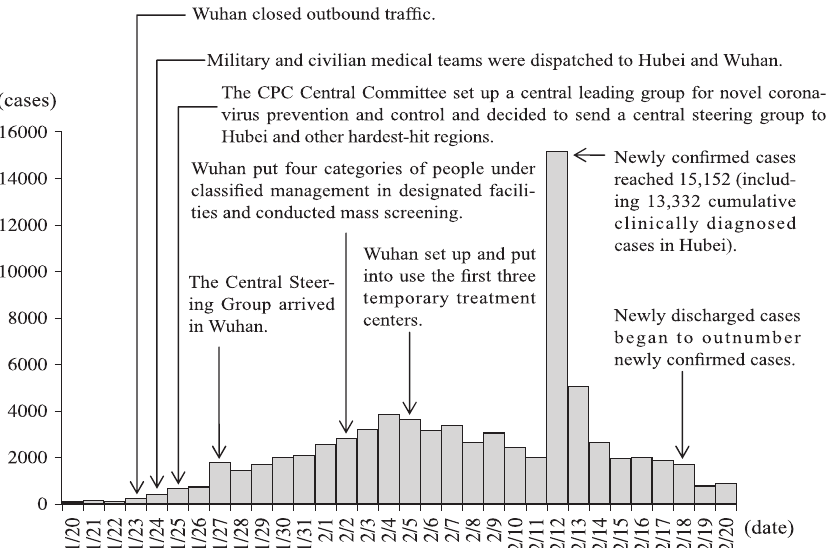
Figure 1. Daily Figure for